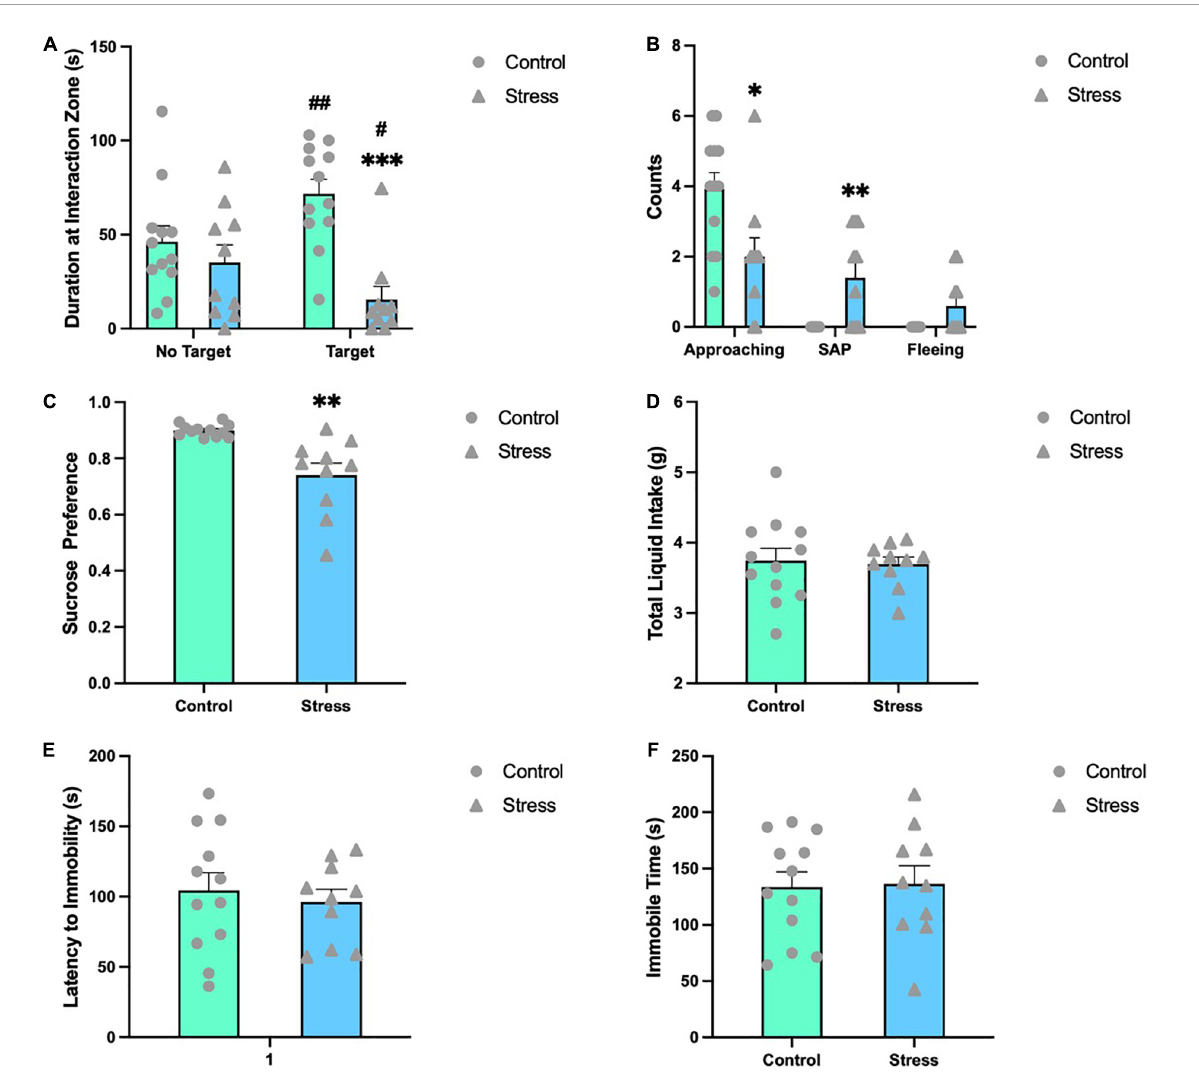
FIGURE2 Chronic social defeat stress (CSDS) induces emotion-related behavioral changes in adolescent mice. (A) CSDS mice spent significantly less time with a novel social target present in the interaction zone compared to no target present. (B) CSDS mice approached less toward the target mouse, exhibited significantly more SAP behaviors and a trend of increase in fleeing frequency than control mice. (C) In the sucrose preference test, stressed mice exhibited a significantly less preference to sucrose solution, while the total liquid consumed was comparable between the two groups (D) . In the forced swimming test, mice in the two groups showed comparable latency to immobility (E) and immobility time (F) . Data are expressed as mean ± SEM (Control, n = 12; Stress, n = 10), ∗ P < 0.05, ∗∗ P < 0.01, ∗∗∗ P < 0.001, Stress vs. Control. # P < 0.05, ## P < 0.01, target vs. no target. SAP, stretched approach